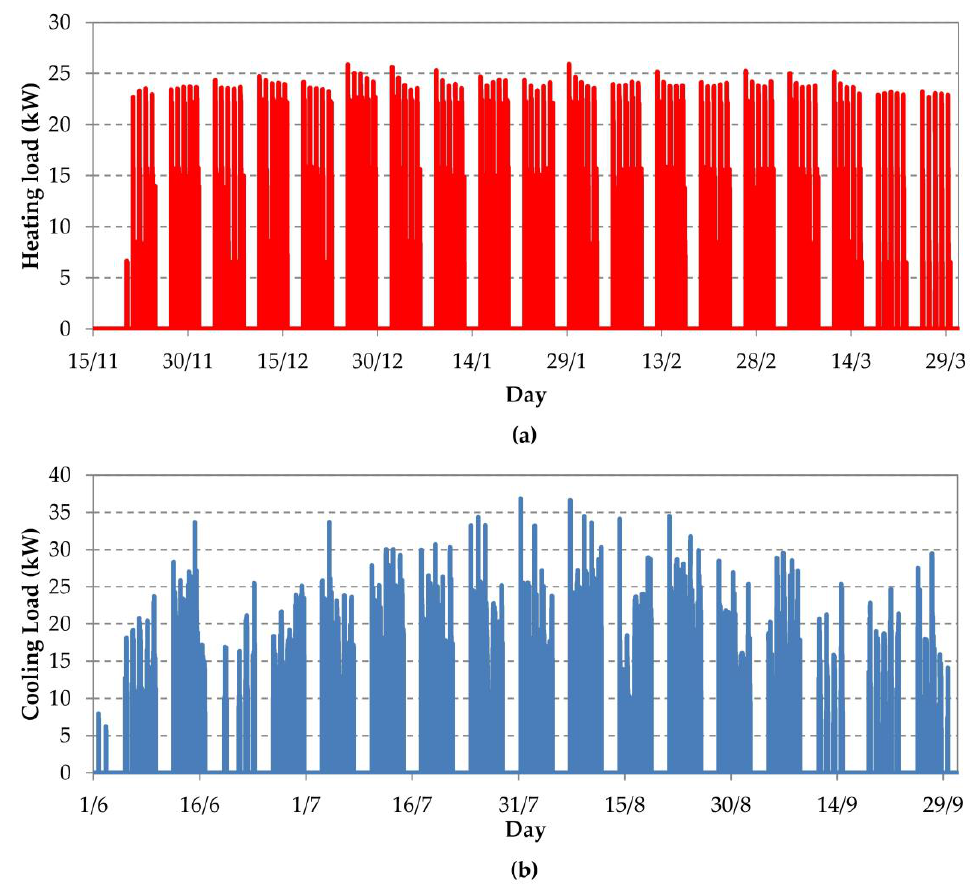
Figure 4. ( a ) Heating and ( b ) cooling loads.